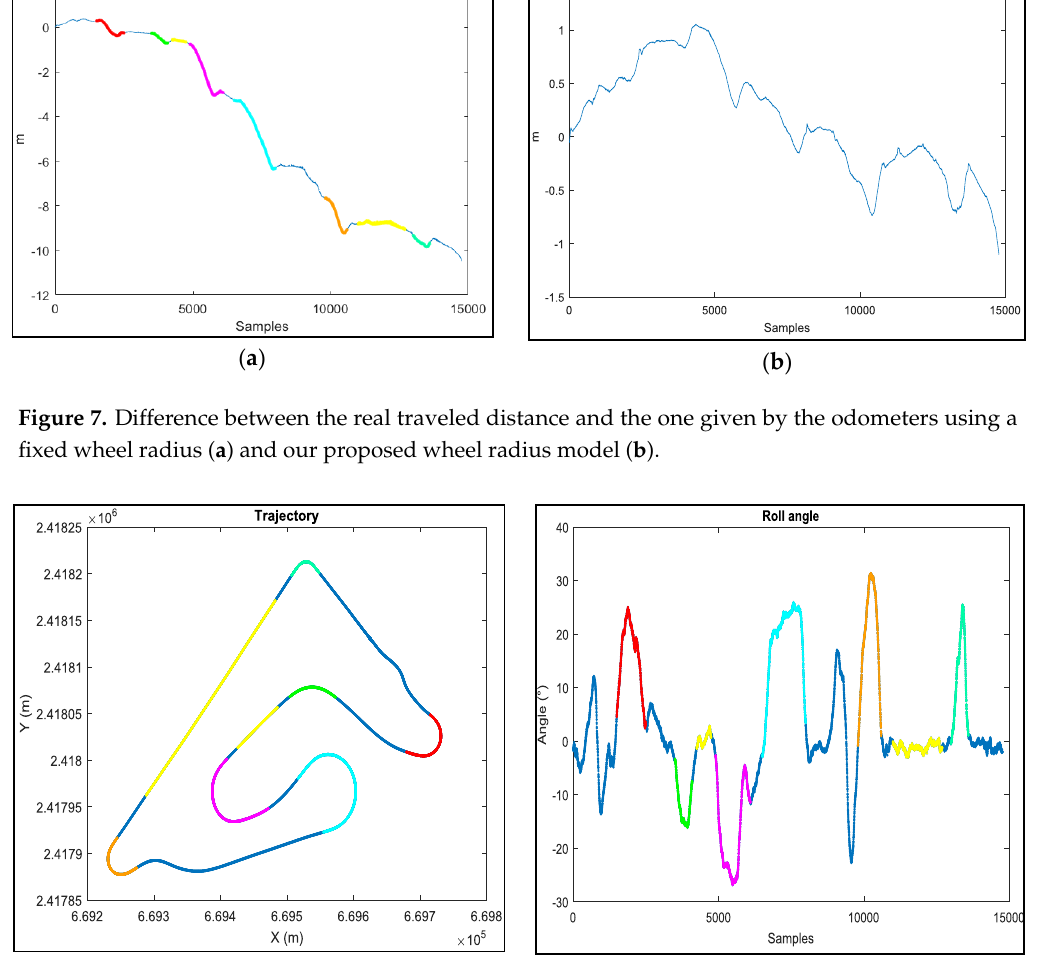
Figure 8. Location of the distance error (fixed radius) of each zone of Figure 7a on the trajectory ( a ) and the corresponding roll angle ( b ).